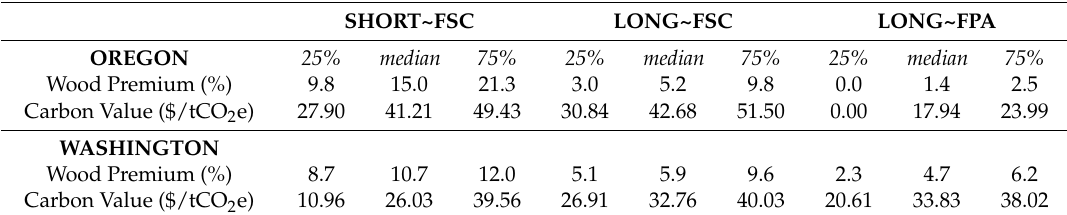
Table 5. Additional value for wood and carbon storage required to close the financial gap of alternative management scenarios with the BAU